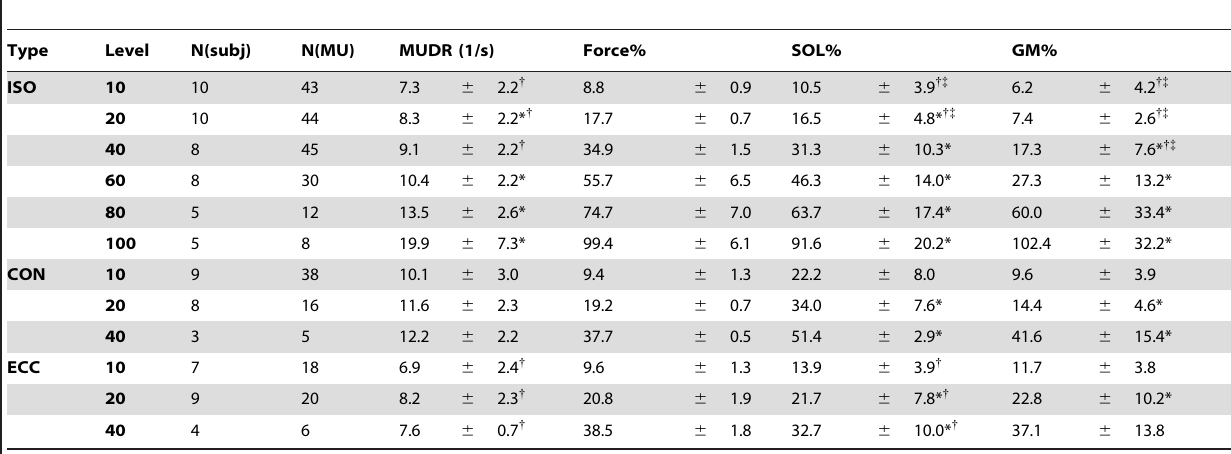
Table 1. Number of subjects and motor units (MU), motor unit discharge rate (MUDR) and relative force and sEMG levels of soleus (SOL) and gastrocnemius medialis (GM) in different conditions.